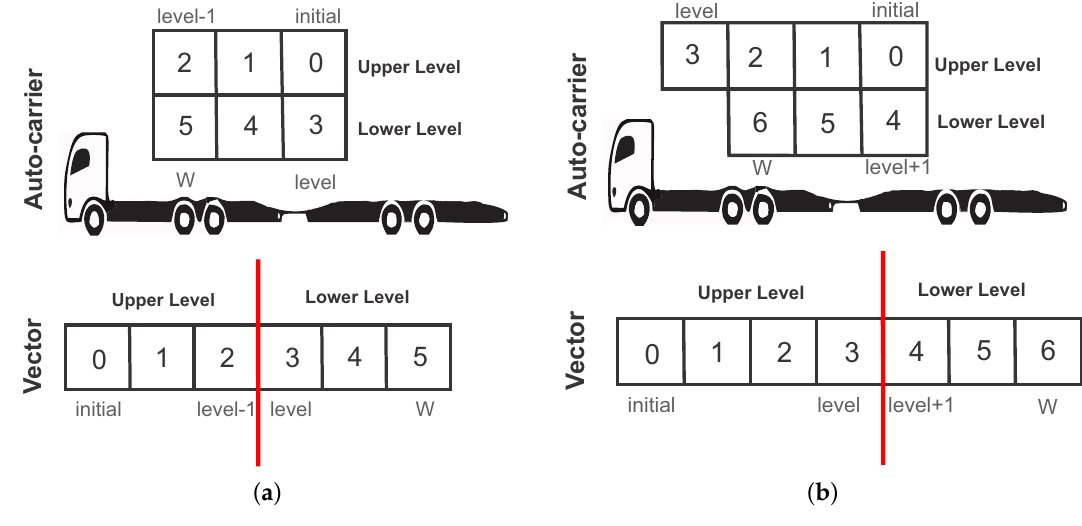
Figure 8. Vector of auto-carrier capacity: ( a ) Pair ( b )